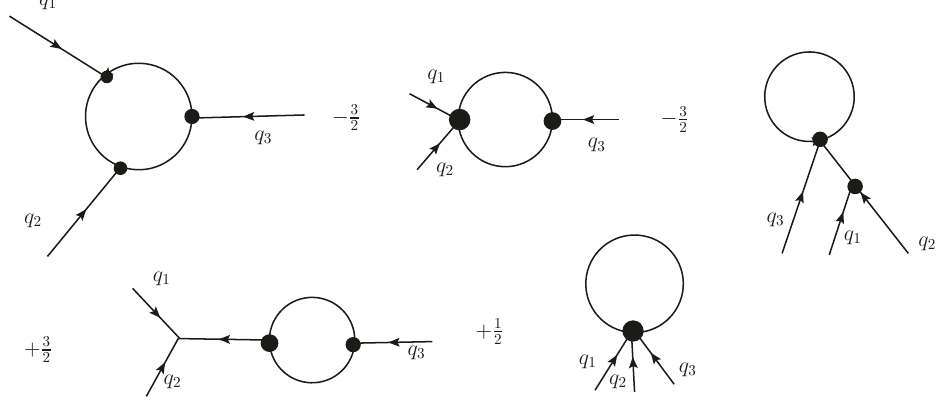
Figure 21. Contributions to the e(cid:11)ective action